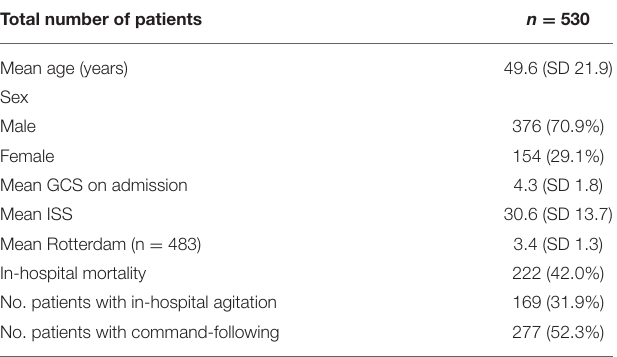
TABLE 1 | Patient characteristics of total study population, n = 530.